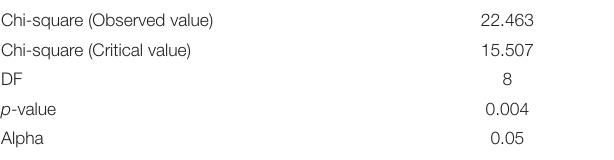
TABLE 6 | Results of Chi-Square test of